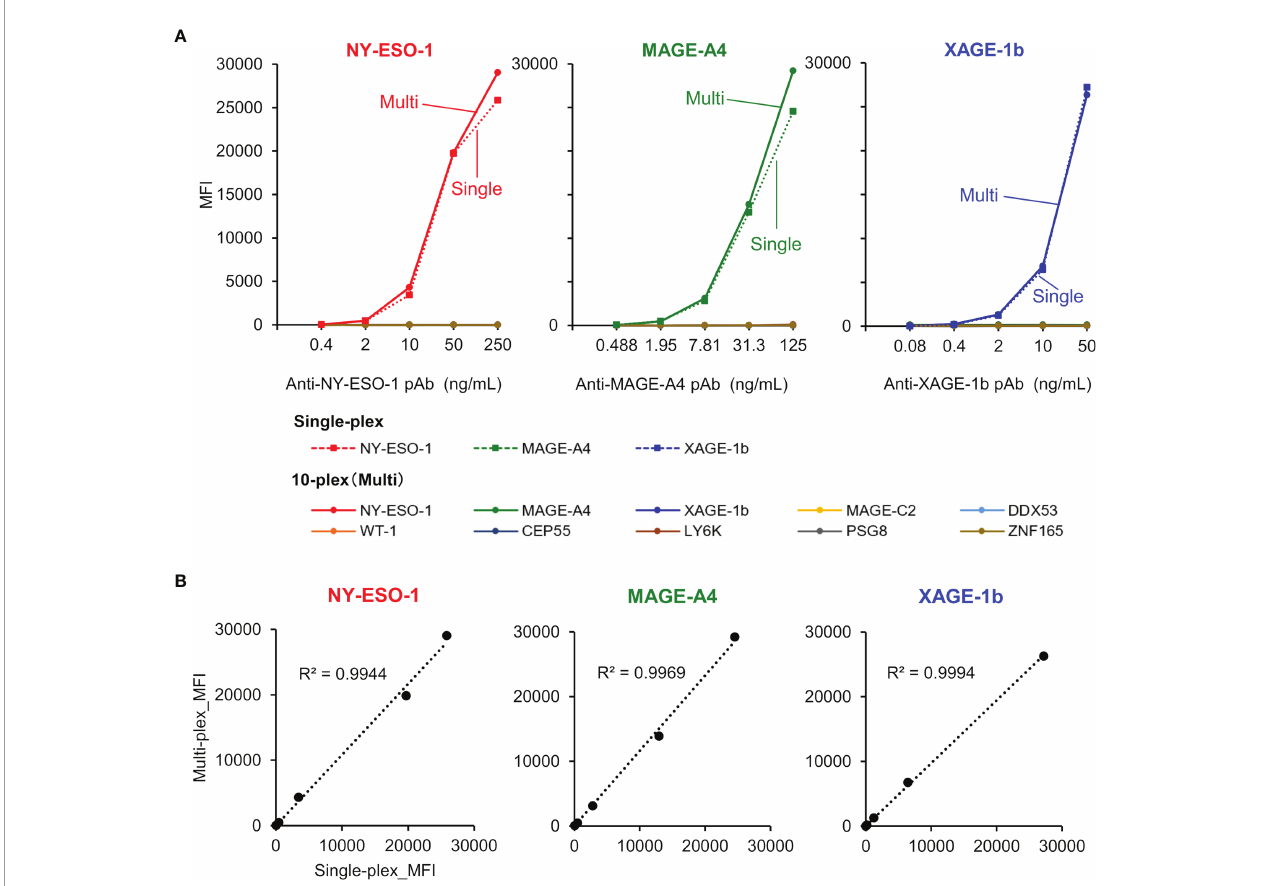
FIGURE 5 | The validation study used puri fi ed rabbit polyclonal anti-CTAs antibodies in the single-plex and 10-plex beads assay. (A) The solid line represents the 10-plex assay, and the dotted line indicates the single-plex assay. (B) Correlation analysis between single-plex and 10-plex